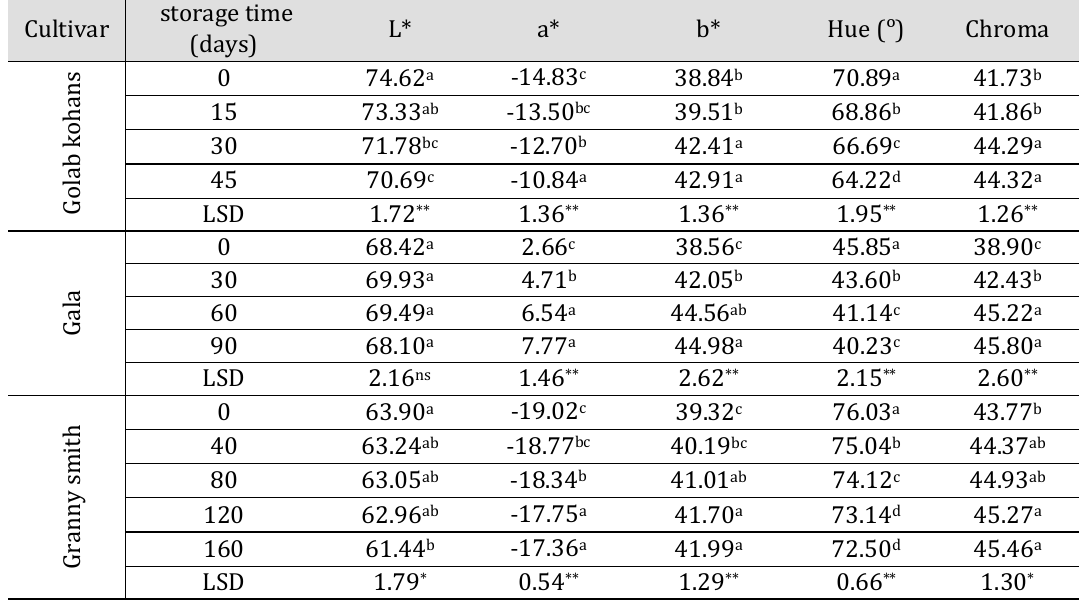
Table 3. Fruit color changes during cold storage period at 0±1 ○ C and 90 - 95 % relative humidity for three apple cultivars (Golab Kohans, Gala and Granny Smith).